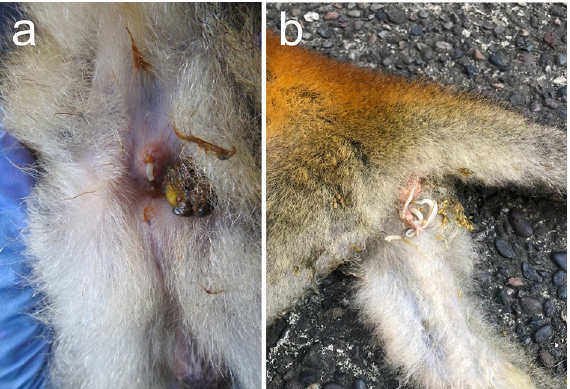
Figure 4. Macroscopic findings of P. elegans in squirrel monkeys. Worms expelled from the anus of S. o. citrinellus during clinical